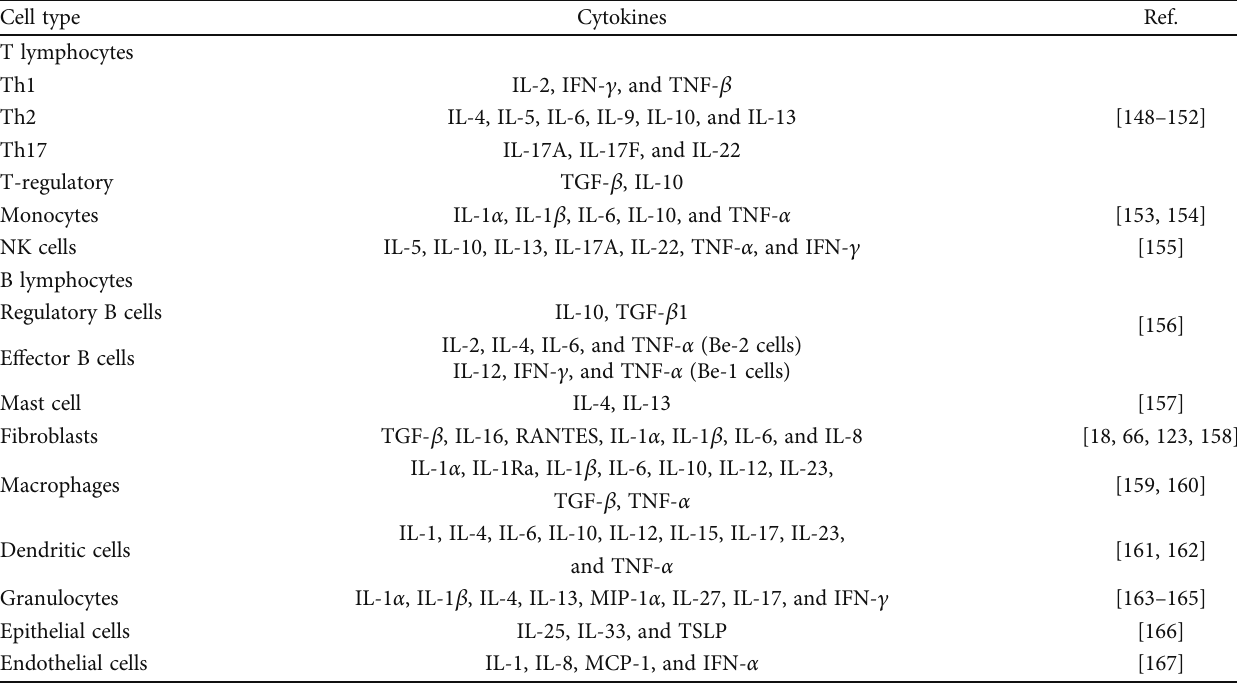
Table 1: TSLP (thymic stromal